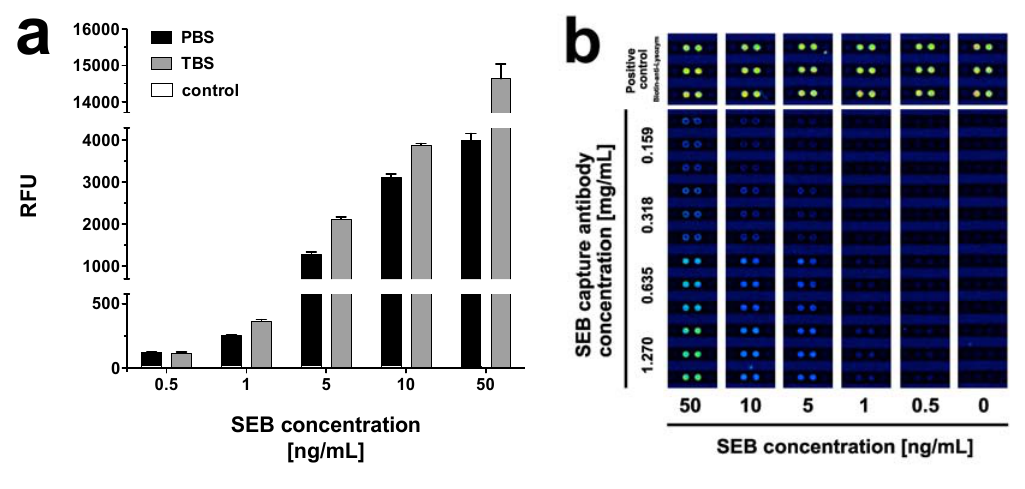
Figure 4. Detection of SEB diluted in PBS and TBS and image of IncaSlide. ( a ) PBS (black bars) and TBS (gray bars) were spiked with SEB (final concentrations 0.5, 1, 5, 10, and 50 ng·mL − 1 ) and slides were processed at 25 °C. Negative control values (white) are integrated in the bars. Average total signal intensity and standard deviation (error bars) were calculated from six features (n = 6) per assay; ( b ) Fluorescence scan image series of IncaSlide sections functionalized with anti-SEB capture antibody and SEB applied at concentrations of 0–50 ng·mL − 1 , diluted in TBS. The respective positive controls (Biotin-anti-Lysozyme) are shown in the top part of the